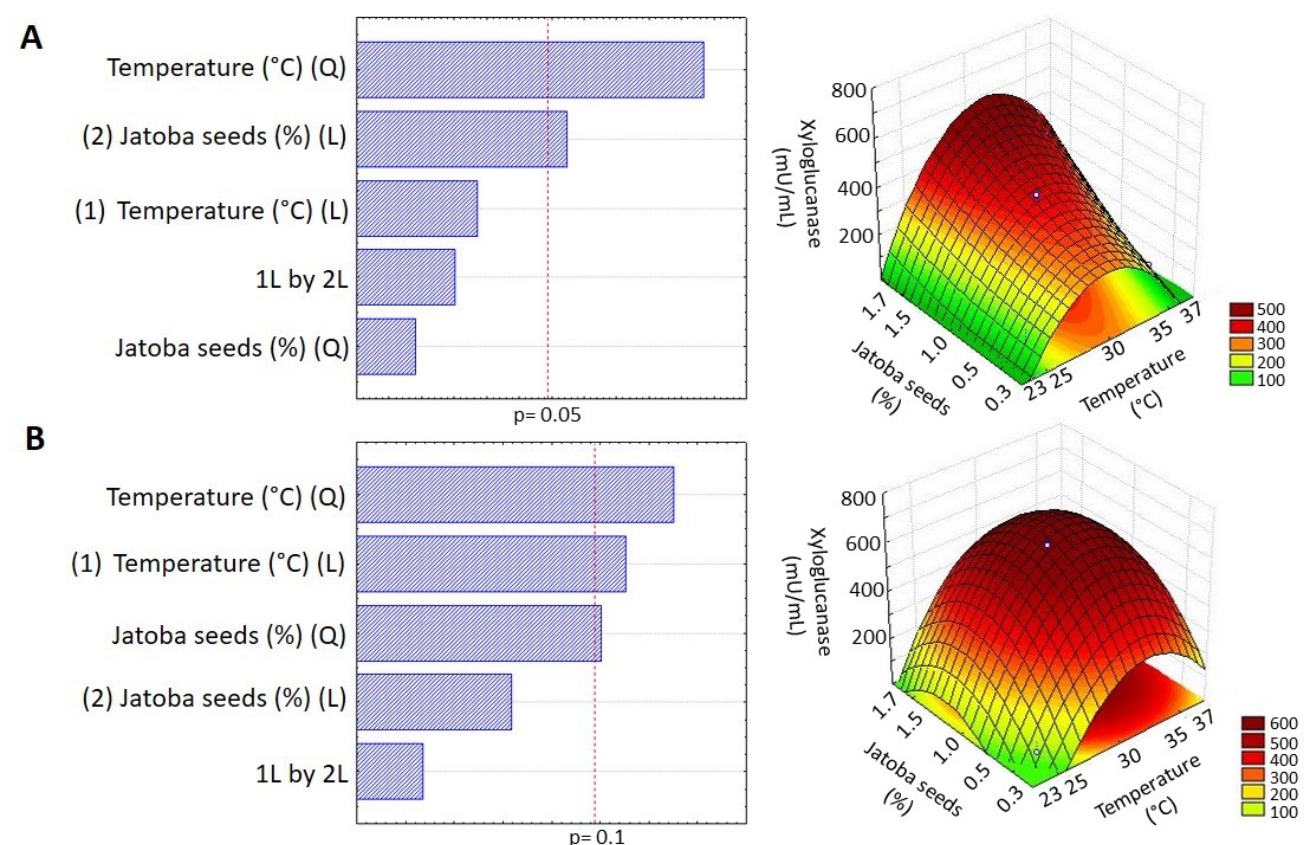
Values are expressed in mU/mL. nd = not detected. Bold values indicate the maximum value found for each time.